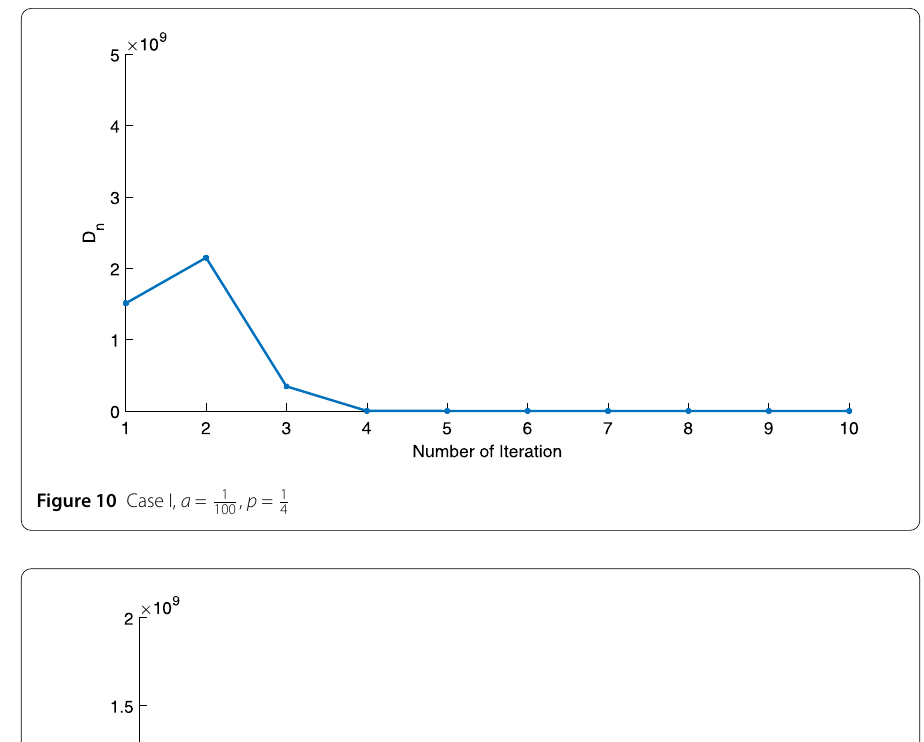
Figure 10 Case I, a = 1